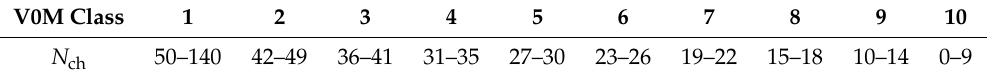
Figure 1. Upper panel: comparison of charged particle p T spectra in pp collisions at ALICE data [20] and Monte Carlo (MC) simulation, which are used for this analysis. Lower panel: the ratio between scaled simulated data and experimental data. Table 1. V0M multiplicity classes and the corresponding charged particle